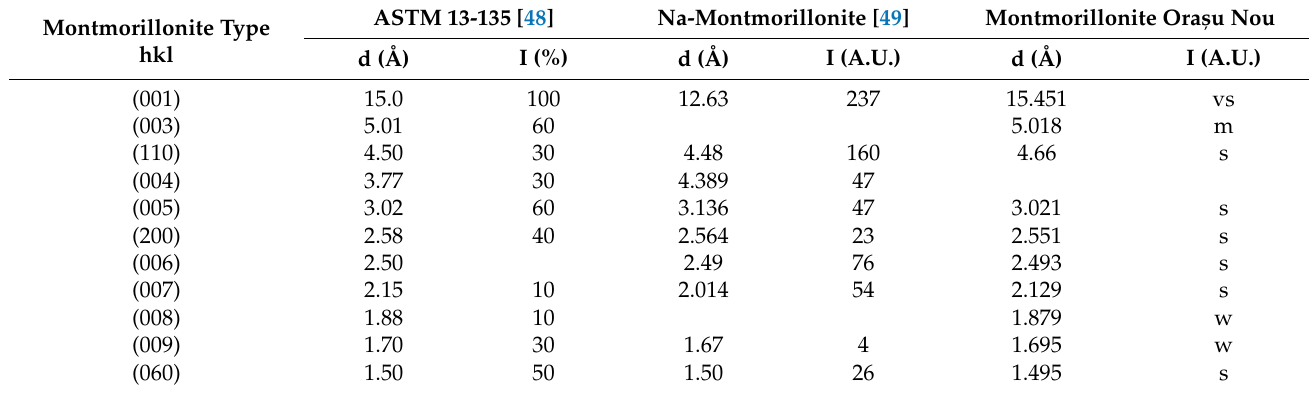
Table 4. Synthetic table of the minerals and their mass fraction limits determined using XRD in the studied bentonites and bentonitized rocks (A.U.—arbitrary units; vs—very strong, s—strong, m—medium, w—weak).